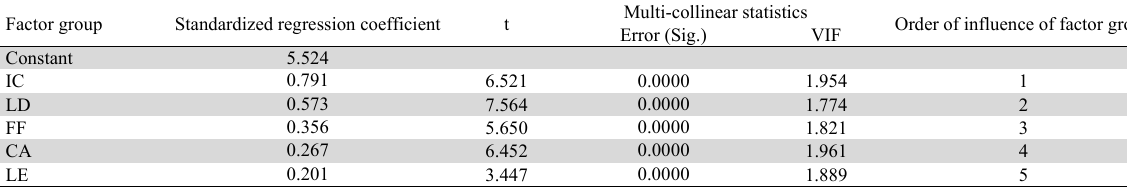
Results of linear regression